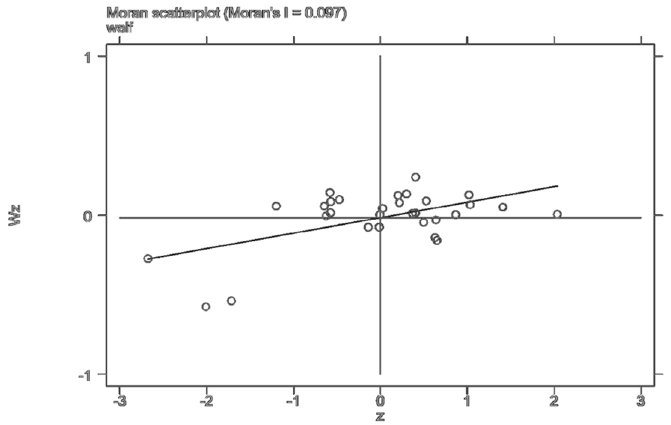
Figure 3. Local Moran scatter plot of residents’ well-being in 2012.